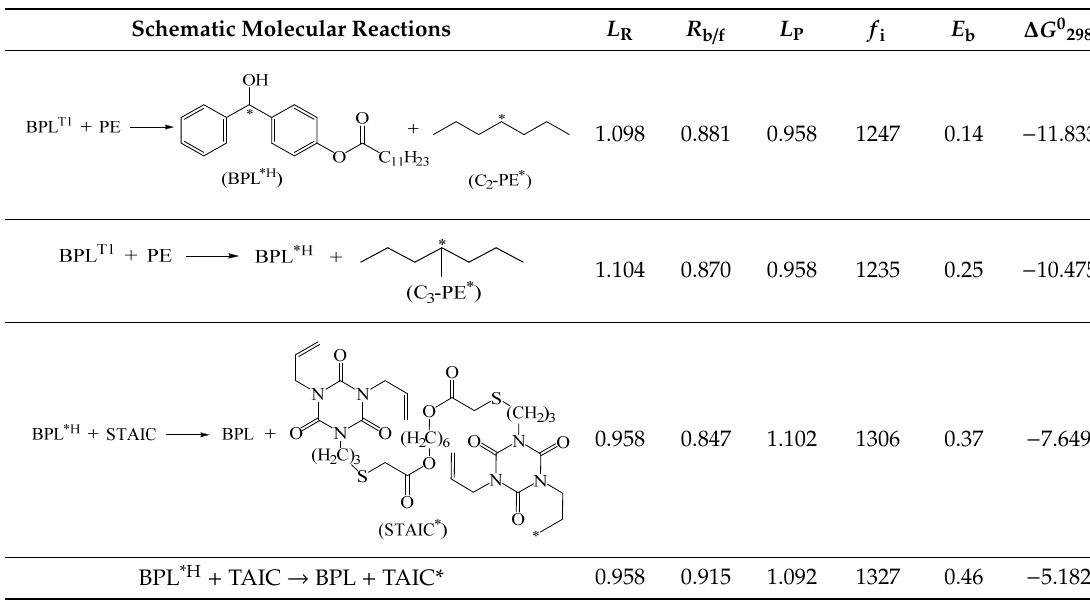
Table 3. Reactant C–H (or O–H) bond length L R (Å) and product O–H (or C–H) bond length L P (Å),